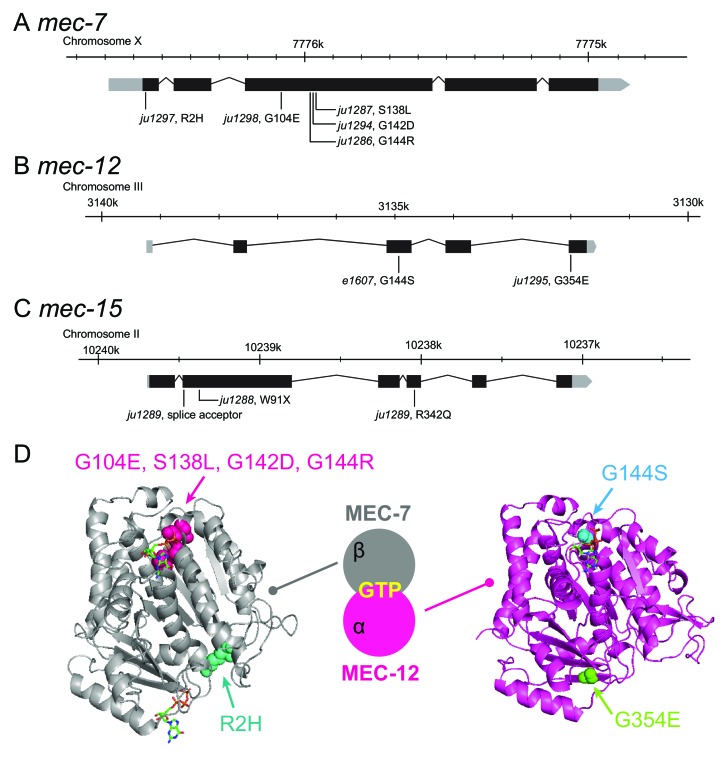
Gene and protein structures of ribosome defective mutants.(A–C) Gene structures of mec-7, mec-12, and mec-15 with alleles and corresponding amino acid changes. Black boxes indicate exons; Grey bars untranslated regions. (D) Three-dimensional structure models of α- and β-tubulins generated by Swiss-Model (Biasini et al., 2014) and a schematic of a tubulin dimer. Non-exchangeable GTP is shown in yellow. MEC-7 model generated with pig β-tubulin (PDB: 1IA0) as a template. Magenta indicates recessive mutants (ju1286, ju1287, ju1294, and ju1297) close to the exchangeable GTP/GDP-binding site; cyan dominant mutant (ju1297). MEC-12 model generated with bovine α-tubulin (PDB: 4I50) as a template. Cyan indicates dominant mutant (ju1295); light green recessive mutant (e1607).